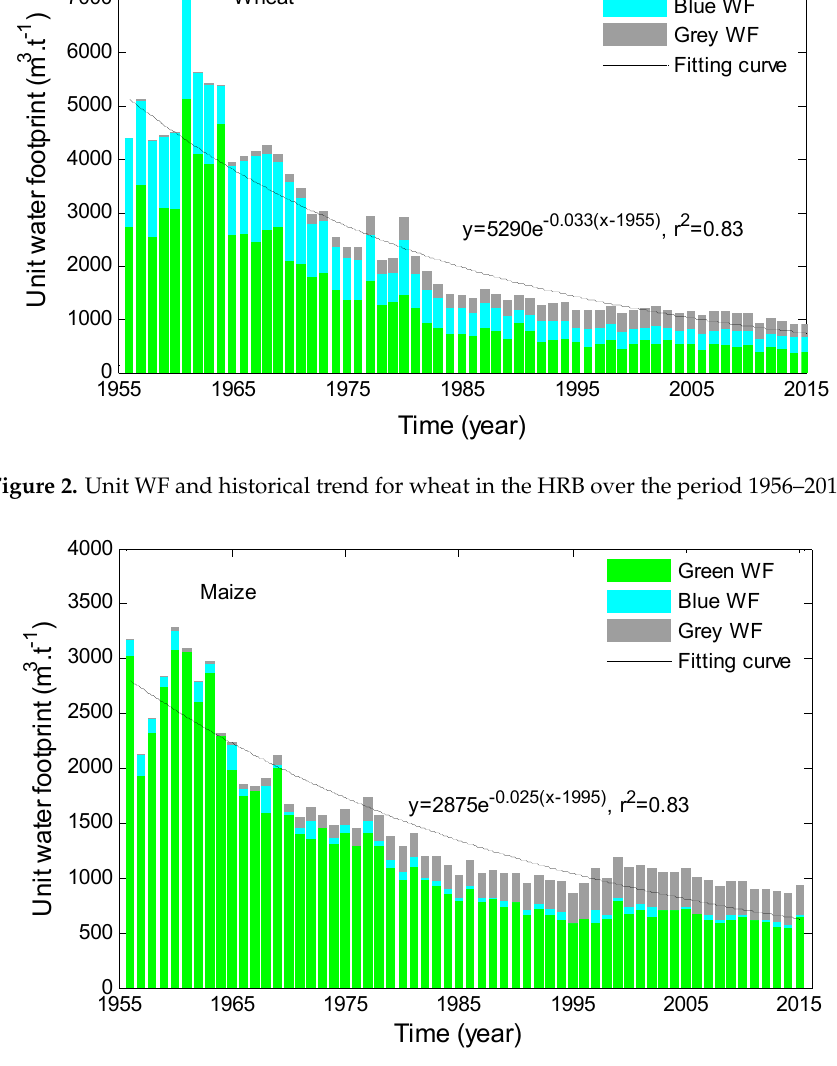
Figure 3. Unit WF and historical trend for maize in the HRB over the period 1956–2015.